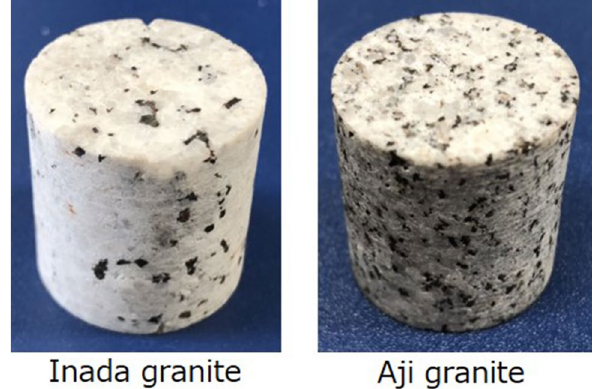
Figure 1. Two types of granite used in chelating agent flooding experiments.